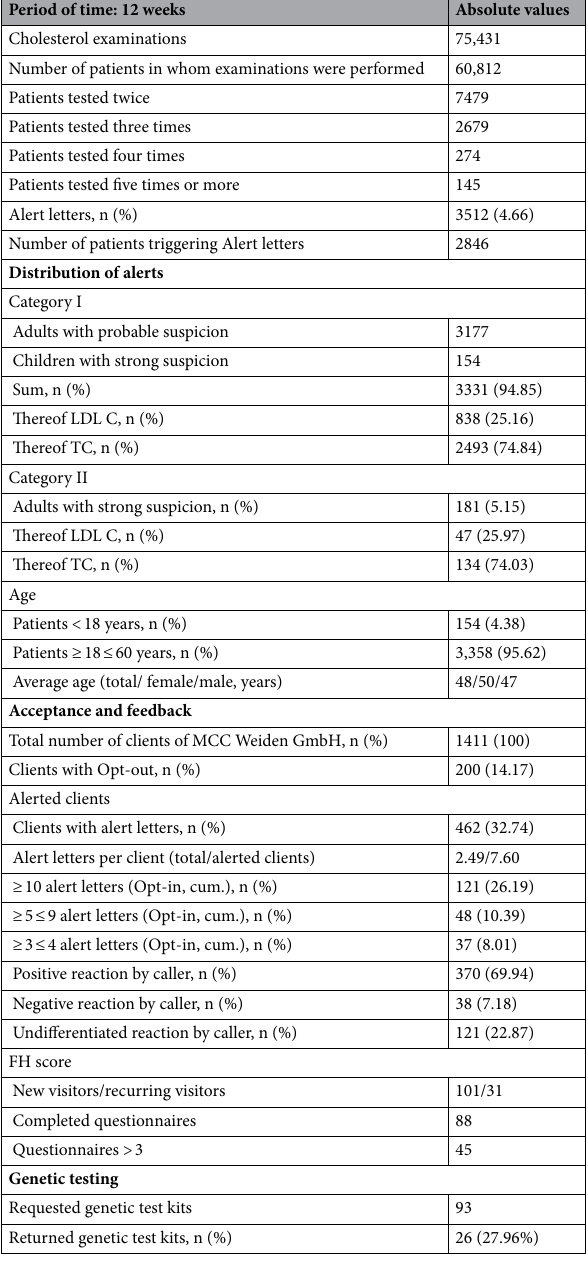
Table 2. FH ALERT’s pilot initiative key results. Data describes general information, distribution of alerts, acceptance, feedback, and genetic